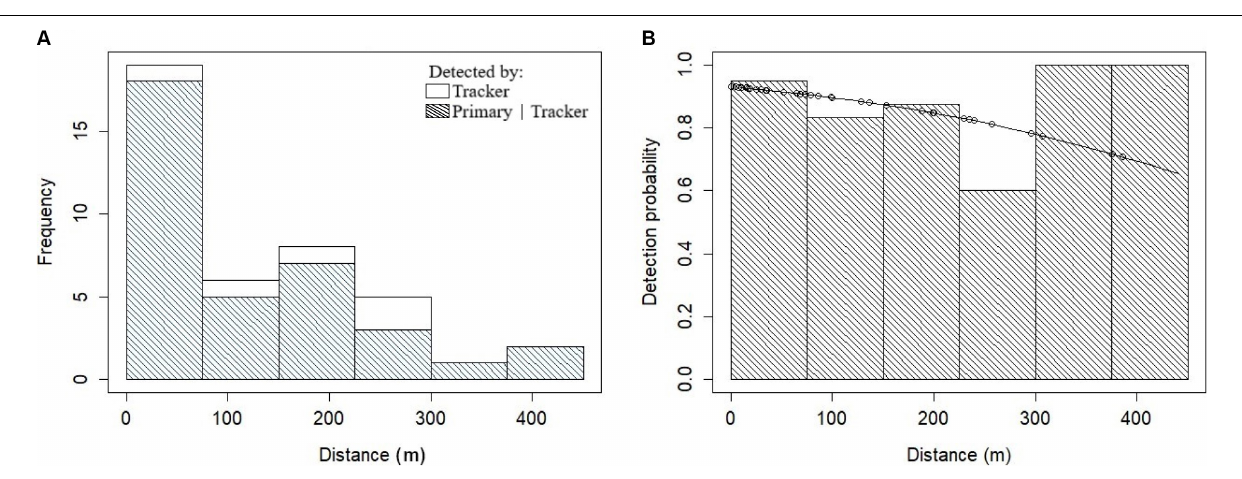
FIGURE 3 | Fitting the dusky dolphin detection function. (A) Histogram of the frequency distributions of the perpendicular distances (m) truncated to 450 m for dusky dolphin groups detected by the tracker platform (i.e., visual). Shading indicates duplicate detections made by the primary platform (i.e., acoustic). (B) The conditional detection function for the primary platform is based on detection by the tracker platform. The solid line is the fitted MR-FI model for the dusky dolphin data and dots represent probabilities for individual